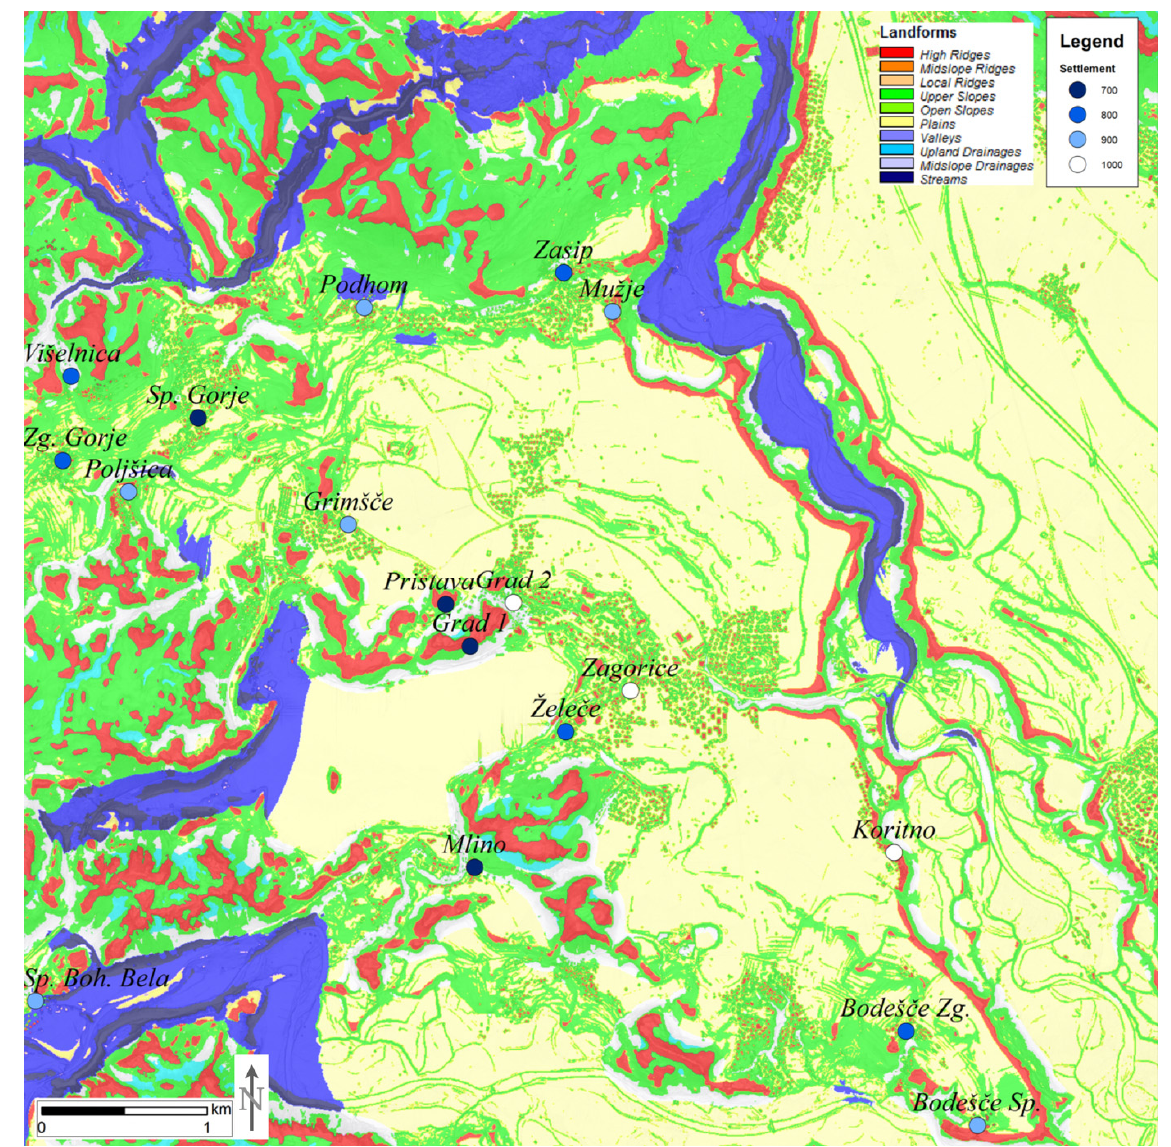
Figure 5. Bled microregion (decimal longitude and latitude coordinates of the map centre: 14.1139; 46.3752), topographic position index-based landform classification.